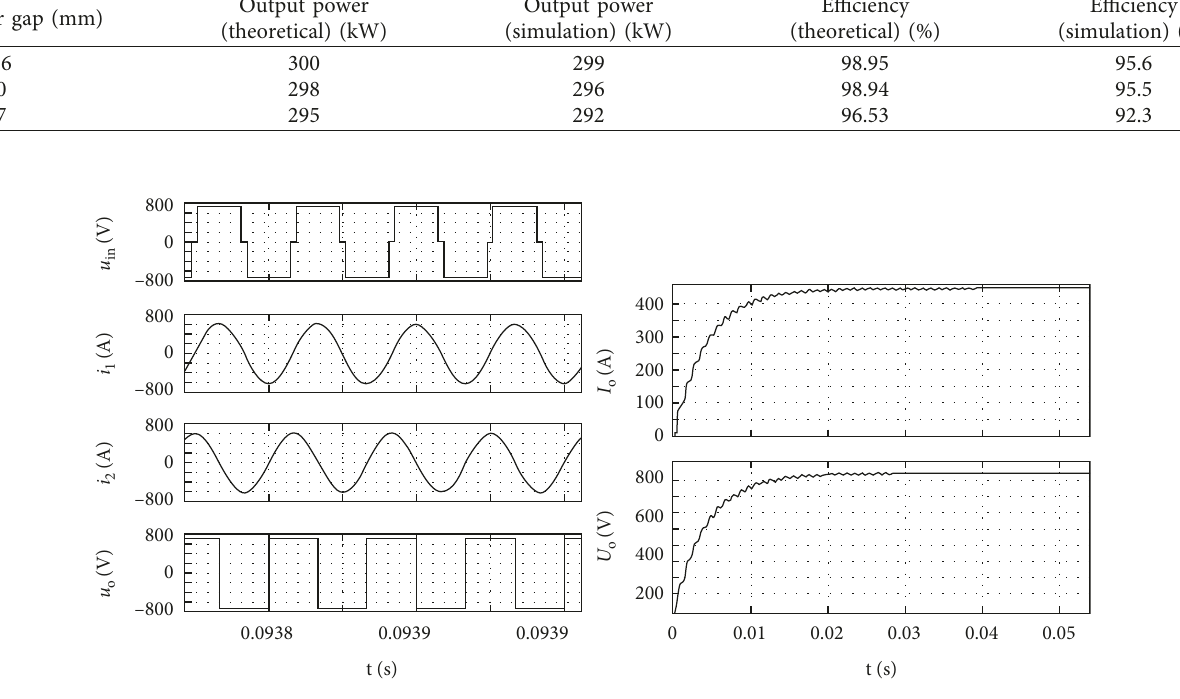
Figure 11: The equivalent load of 5 MATLAB simulation results. Ω Table 4: Electromagnetic radiation